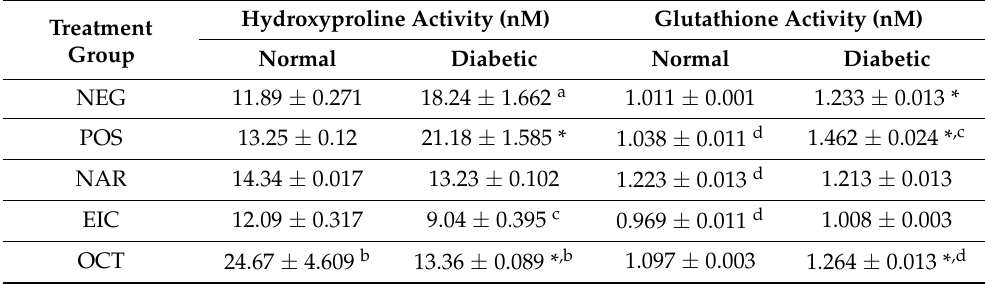
Table 3. Hydroxyproline and glutathione activity of different treatments in normal and diabetic groups. Hydroxyproline Activity (nM) Glutathione Activity (nM) Treatment Group Normal Diabetic Normal Diabetic NEG 11.89 ± 0.271 18.24 ± 1.662